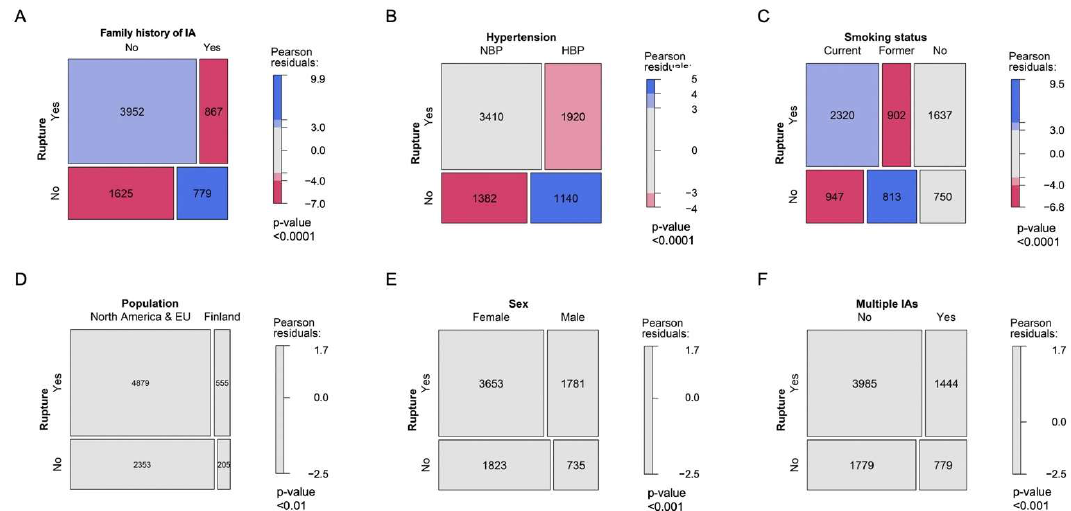
Figure 2. Patient characteristics and diagnosis of aSAH. Effect of family history of IA ( A ), blood pressure ( B ), smoking status ( C ), patient geographic location ( D ), sex ( E ), and IA multiplicity ( F ) on IA rupture status at diagnosis.